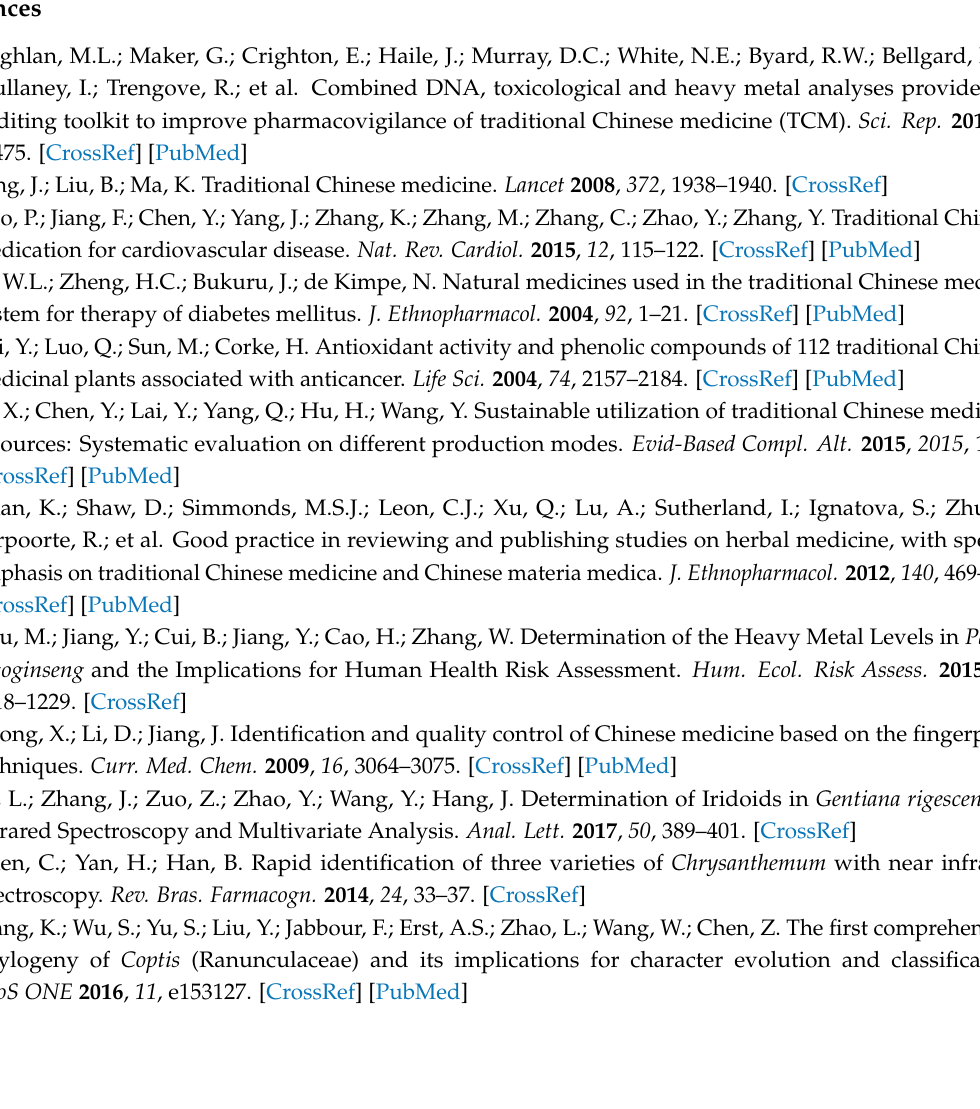
Figure S4: Principal components explaining variances used in PCA according to quantitative determination of alkaloid compounds. Figure S5: Length distribution of RAD-seq contigs. Table S1: Materials of four Coptis plants used in this study. Table S2: The validation of HPLC-UV method. Table S3: Statistical summary of MIDs, raw reads, filtered reads of each Coptis plants from